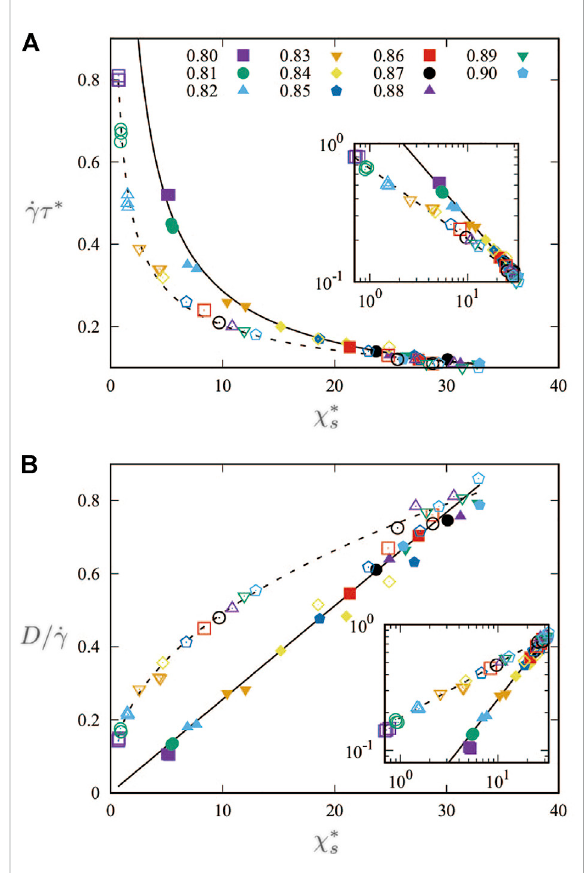
FIGURE 4 (A) The peak position of dynamic susceptibility, _ γτ *, and (B) diffusion coef fi cient over the shear rate, D / _ γ , as functions of the maximum intensity of dynamic heterogeneities, χ p s , where the packing fraction ϕ increases as listed in the legend of (A) . The solid (open) symbols are the results of model A (B), where we only show the data in a quasi-static regime, _ γ t 0 ≤ 10 − 5 (10 – 4 ). In (A) , the solid (dashed) line is a power-law fi t, _ γτ * ~ χ p − 0 . 82 s ( χ p − 0 . 51 s ) , to the data of model A (B). In (B) , the solid line is the linear scaling, D / _ γ ~ χ p s , for the results of model A, while the dashed line is a power-law fi t, D / _ γ ~ χ p 0 . 43 s , to the data of model (B). The insets are double logarithmic